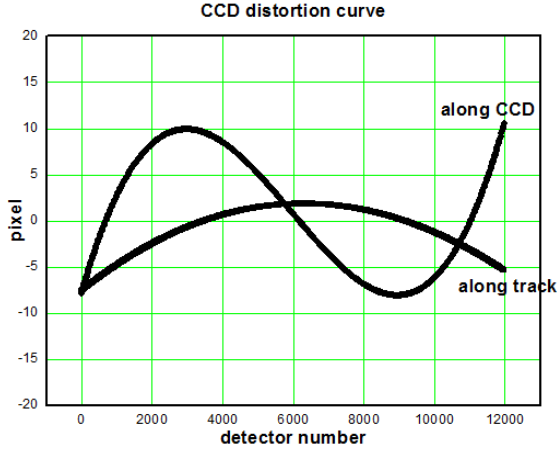
Figure 5. CCD distortion curve of the ZY1-02C panchromatic